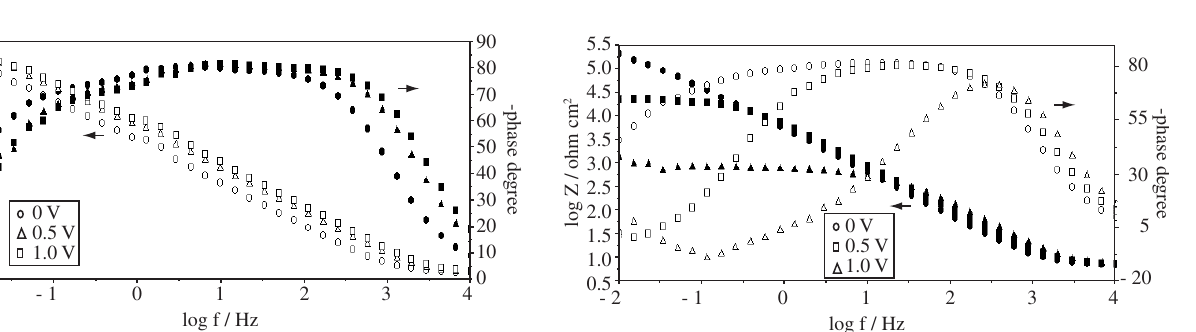
Figure 11. Bode plots of Ti6Al4V obtained in the presence of iodide after anodic polarization at 0 ( ● ), 0.5 ( ■ ) and 1.0 ( ▲ )